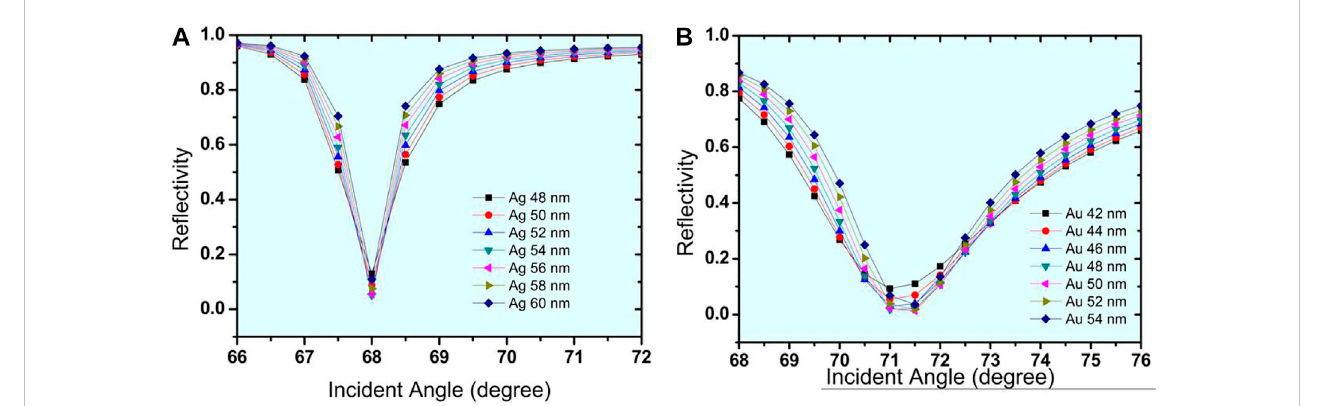
FIGURE 2 Optimization of the thickness of (A) . Ag and (B) Au metals in Kreschmann con fi guration.